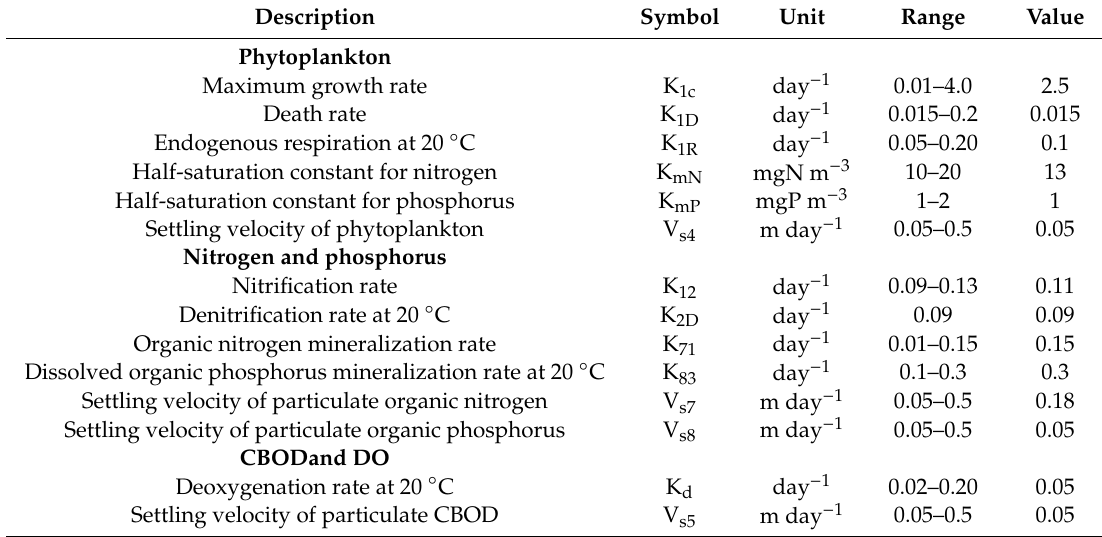
Table 1. Values of major model coe ffi cients used in the WQDPM for Euiam